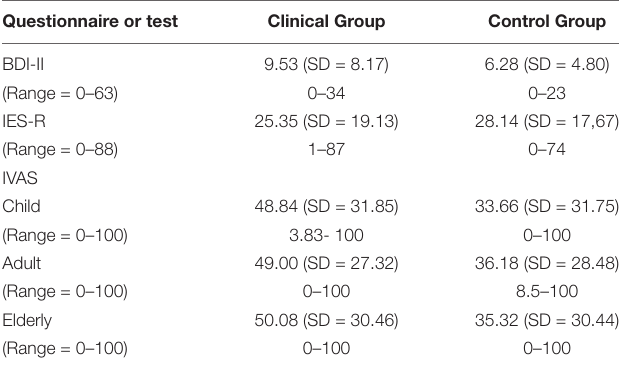
TABLE 2 | Mean scores at BDI-II, IES-R, and IVAS of the clinical group and the control group. Questionnaire or test